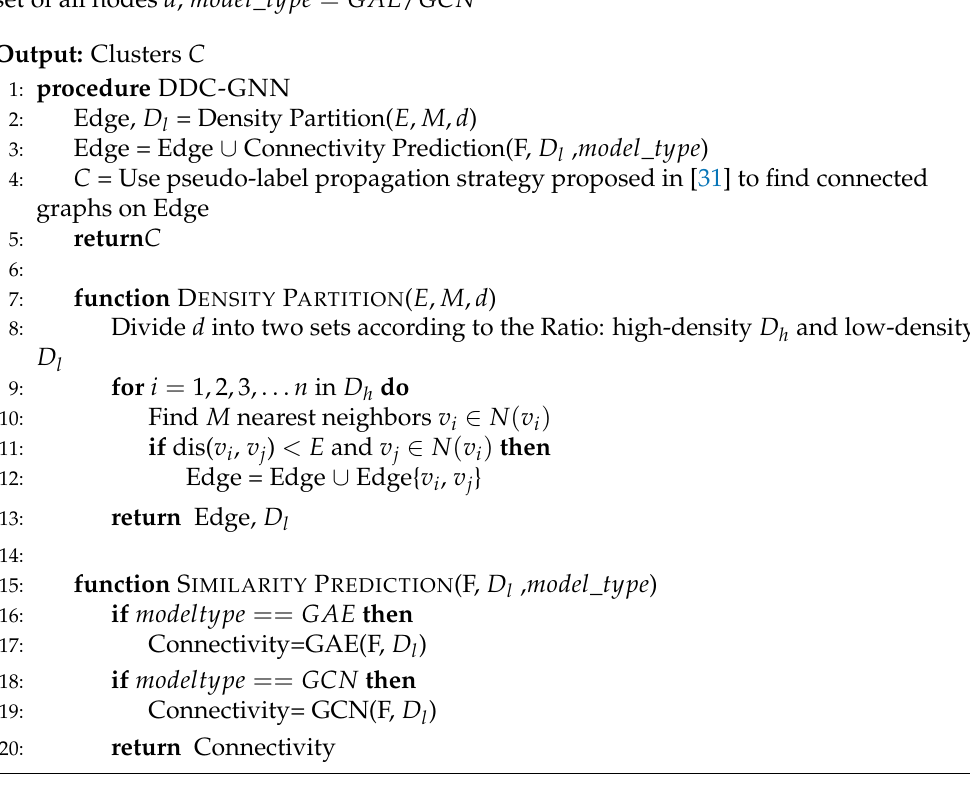
Algorithm 1 supervised clustering based on density